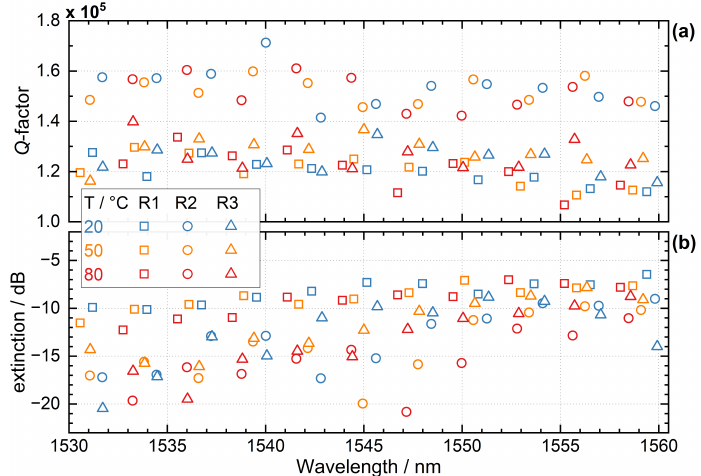
Figure 3. Q -factor ( a ) and extinction ratio ( b ) of the three ring resonators between 1530nm to 1570nm for different temperatures of the thermostated platform.